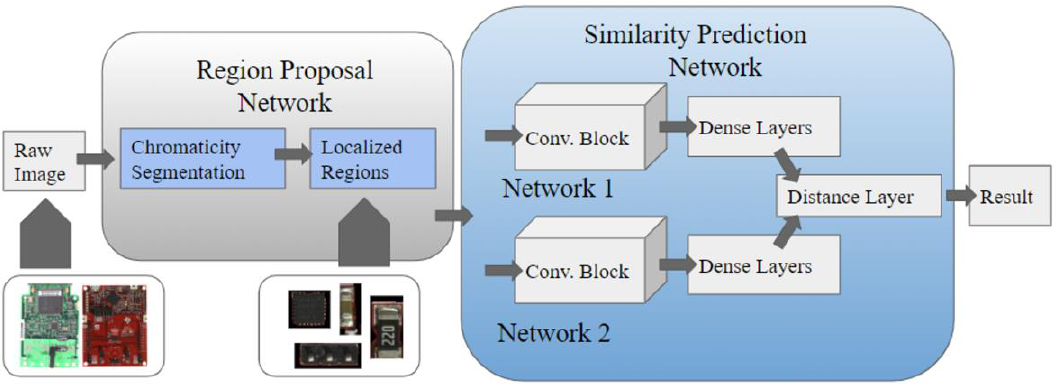
Figure 39. The Electronic Component Localization and Detection Network (ECLAD-Net) architecture for PCB component detection [121]. Abbreviations used: Conv Block, Convolutional Block.